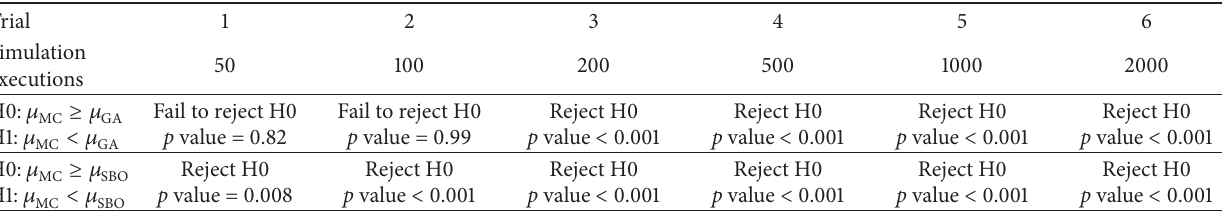
Table 5: Results of statistical hypothesis testing for mean of 50 most challenging test cases.